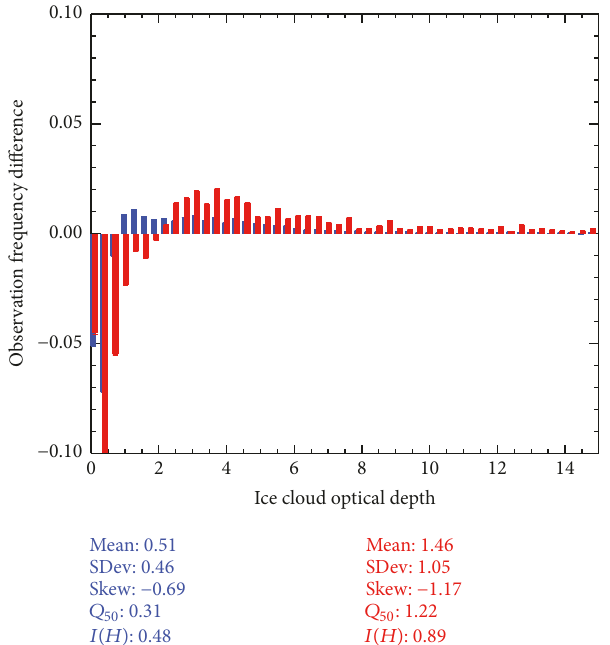
Figure 6: Difference Δ𝐻( COD ) between observed ice cloud optical depth histogram 𝐻( COD ) for the moderate (blue) and high (red) dust loading subsets and Bayesian estimator accompanying distribution statistics